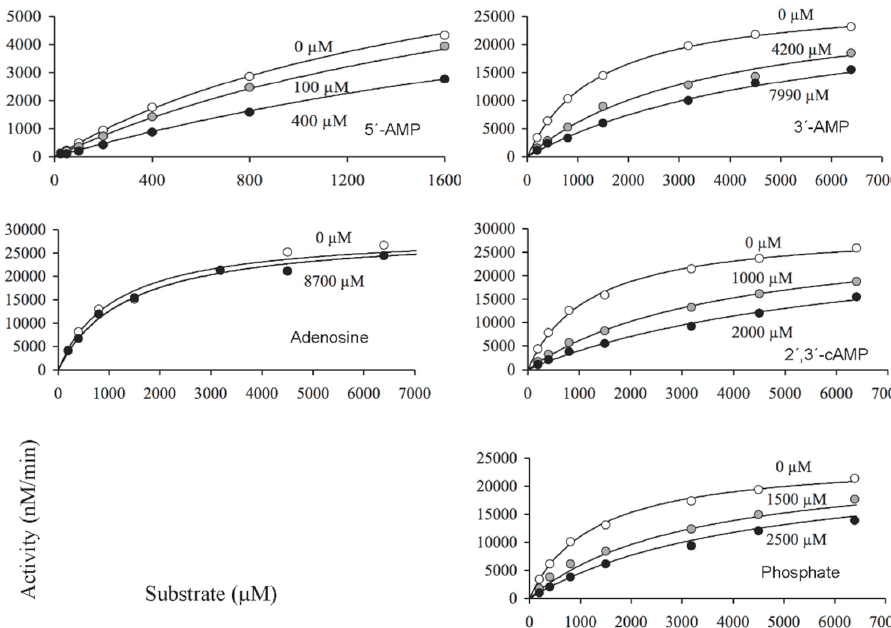
Figure 7. Kinetic analysis of the inhibition of CpdB_Ndom by alternative substrates and non-substrates of the enzyme. Saturation curves by bis-4-NPP were recorded in the absence or in the presence of two (only one for adenosine) fixed concentrations of the compound tested as an inhibitor (data indicated in each panel). The curves of each panel were obtained by globally fitting the equation for complete competitive inhibition to all the experimental data. Each panel shows a representative experiment of three independent ones. The inhibition constants ( K i ) estimated after these adjustments are summarized in Table 2.